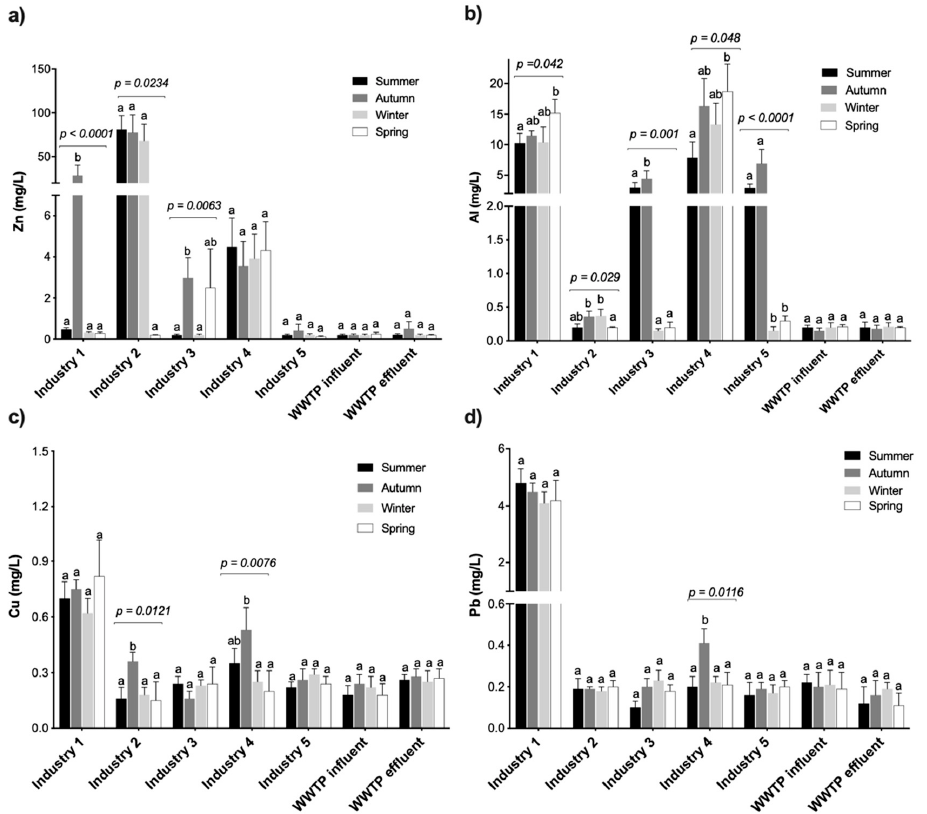
Figure 3. Seasonal variability of toxic heavy metal compositions in the industrial and Leeuwkuil WWTP discharges. Mean values followed by different letters (a and b) within a sampling point are WWTP discharges. Mean values followed by di ff erent letters (a and b) within a sampling point are statistically different (ANOVA; Tukey’s test, p < 0.05). p -Values of the waste streams showing statistically di ff erent (ANOVA; Tukey’s test, p < 0.05). p -Values of the waste streams showing significant differences between seasons are provided.